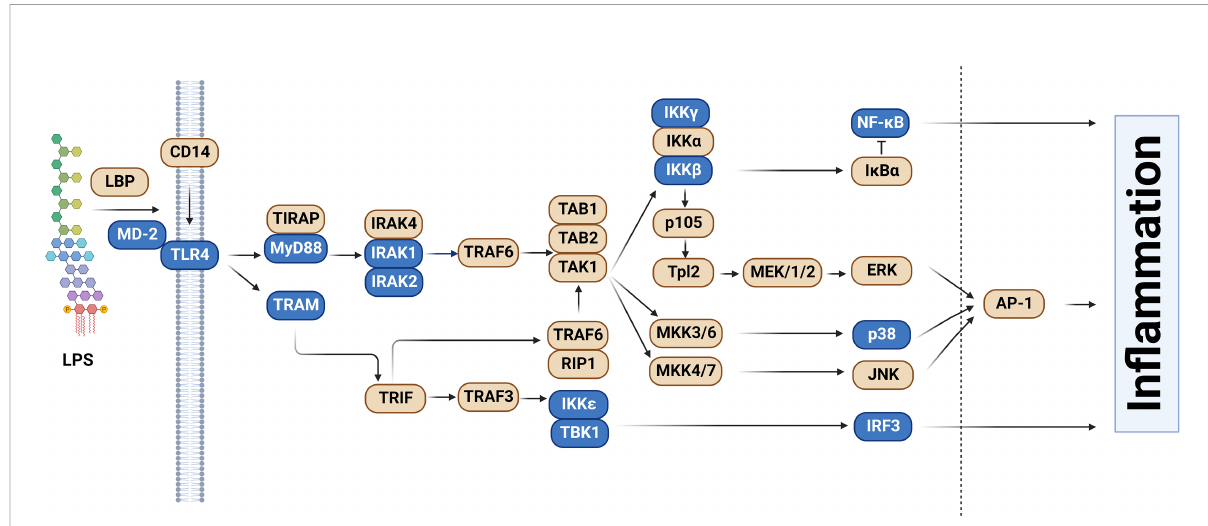
FIGURE 1 Splice forms that encode inhibitors of signaling in the Toll-like receptor signaling pathway. The schematic depicts the Toll-like receptor (TLR) signaling pathway, adapted and modi fi ed from the KEGG pathway database (6, 7). Genes color-coded in blue, in addition to producing the canonical splice forms that encode positive mediators of signaling, also produce alternative mRNA splice forms that encode inhibitors of TLR signaling. Figure created with